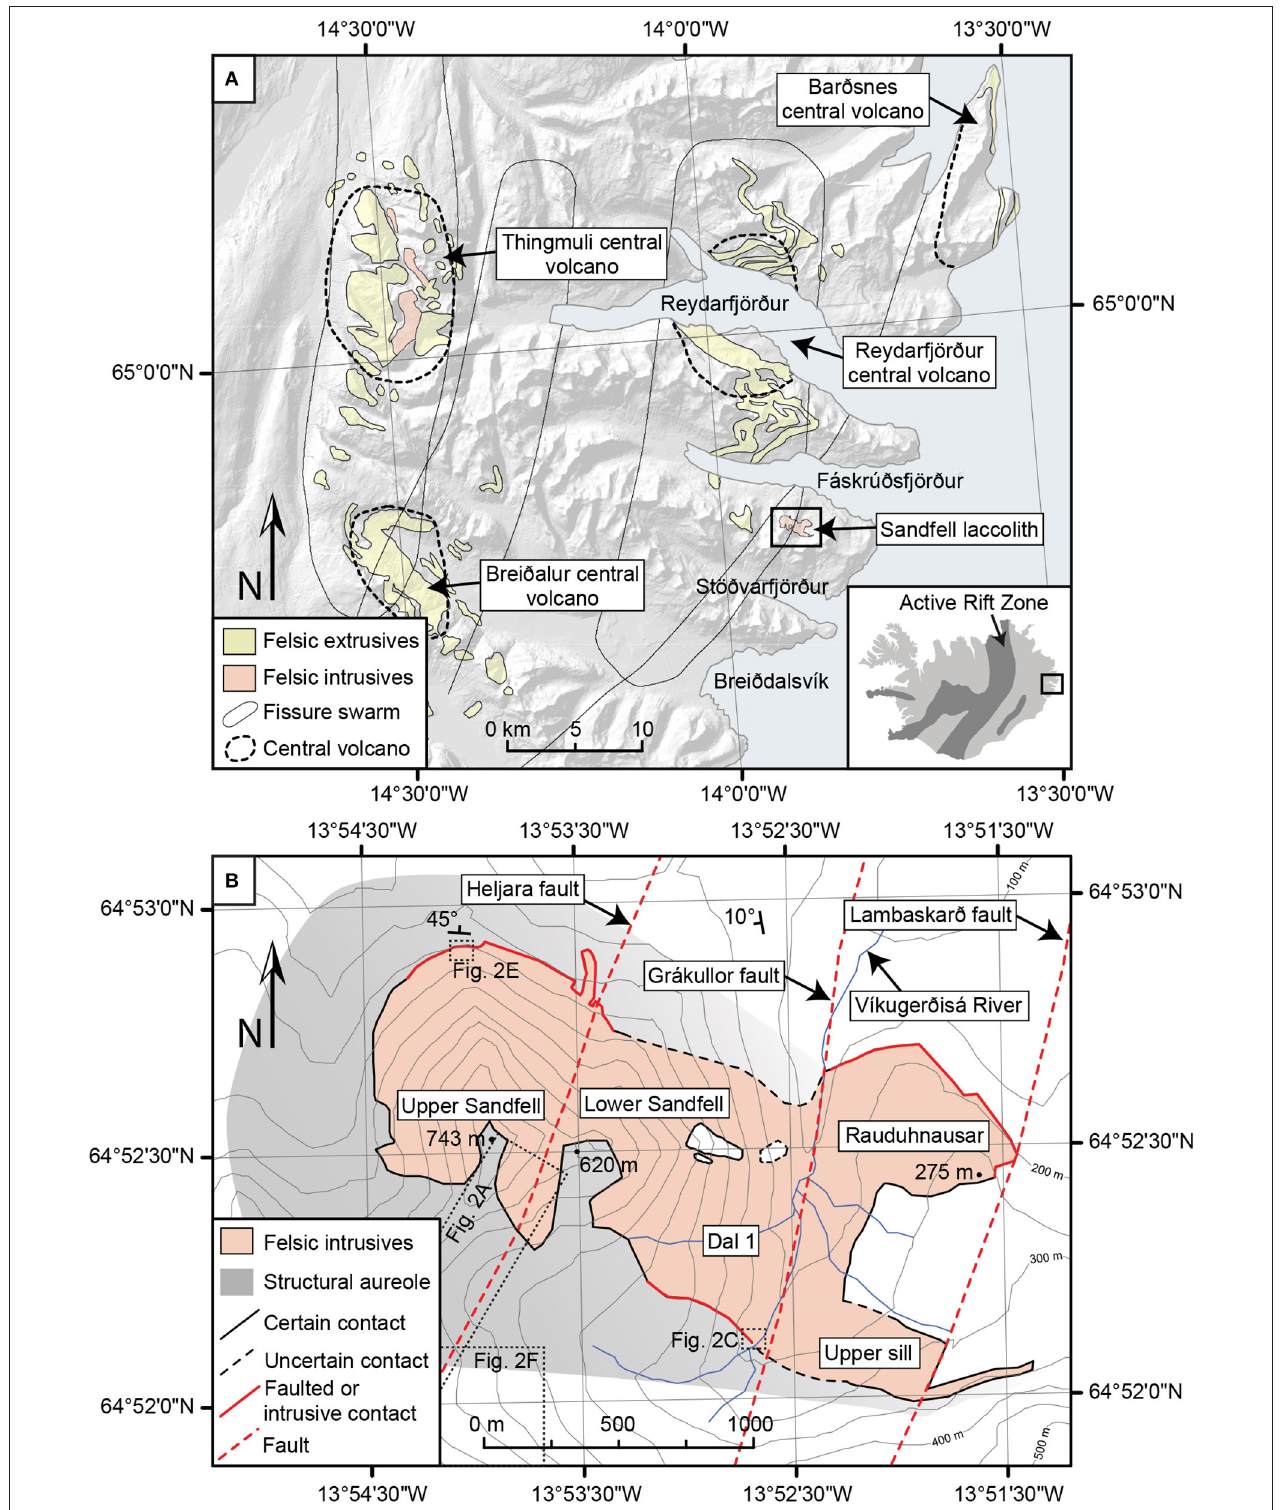
FIGURE 1 | (A) Map of locations of exposed fissure swarms and central volcanoes in the East fjords of Iceland (based on data from National Land Survey of Iceland, http://www.lmi.is/wp-content/uploads/2013/10/License-for-use-of-free-NLSI-data-General-Terms.pdf). (B) Map of the Sandfell laccolith. The structural aureole includes the country rock that is folded, rotated, faulted, and fractured by the emplacement of the Sandfell laccolith. The structural aureole is less pronounced in the eastern part of the laccolith (shown by the gray gradient). Stippled boxes show locations of images in Figures 2A,C,E,F .